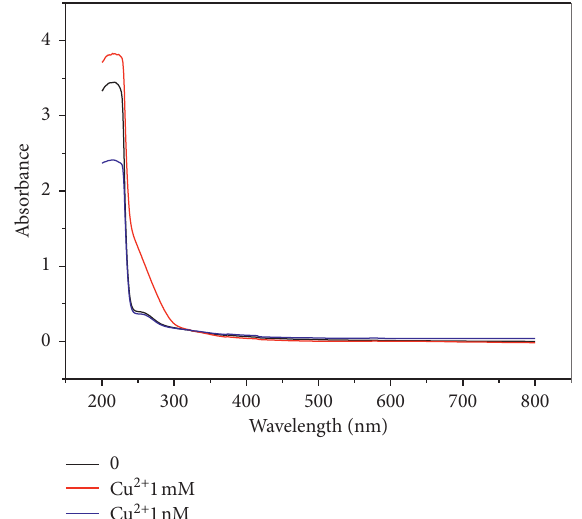
Figure 7: UV-Vis absorption spectrum of the Ag NCs upon addition of different concentrations of Cu 2+ . Table 1: Application of the probe for Cu 2+ in real samples (data are average of three replicate measurements). Cu 2+ (pM) Sample Added Found Mineral